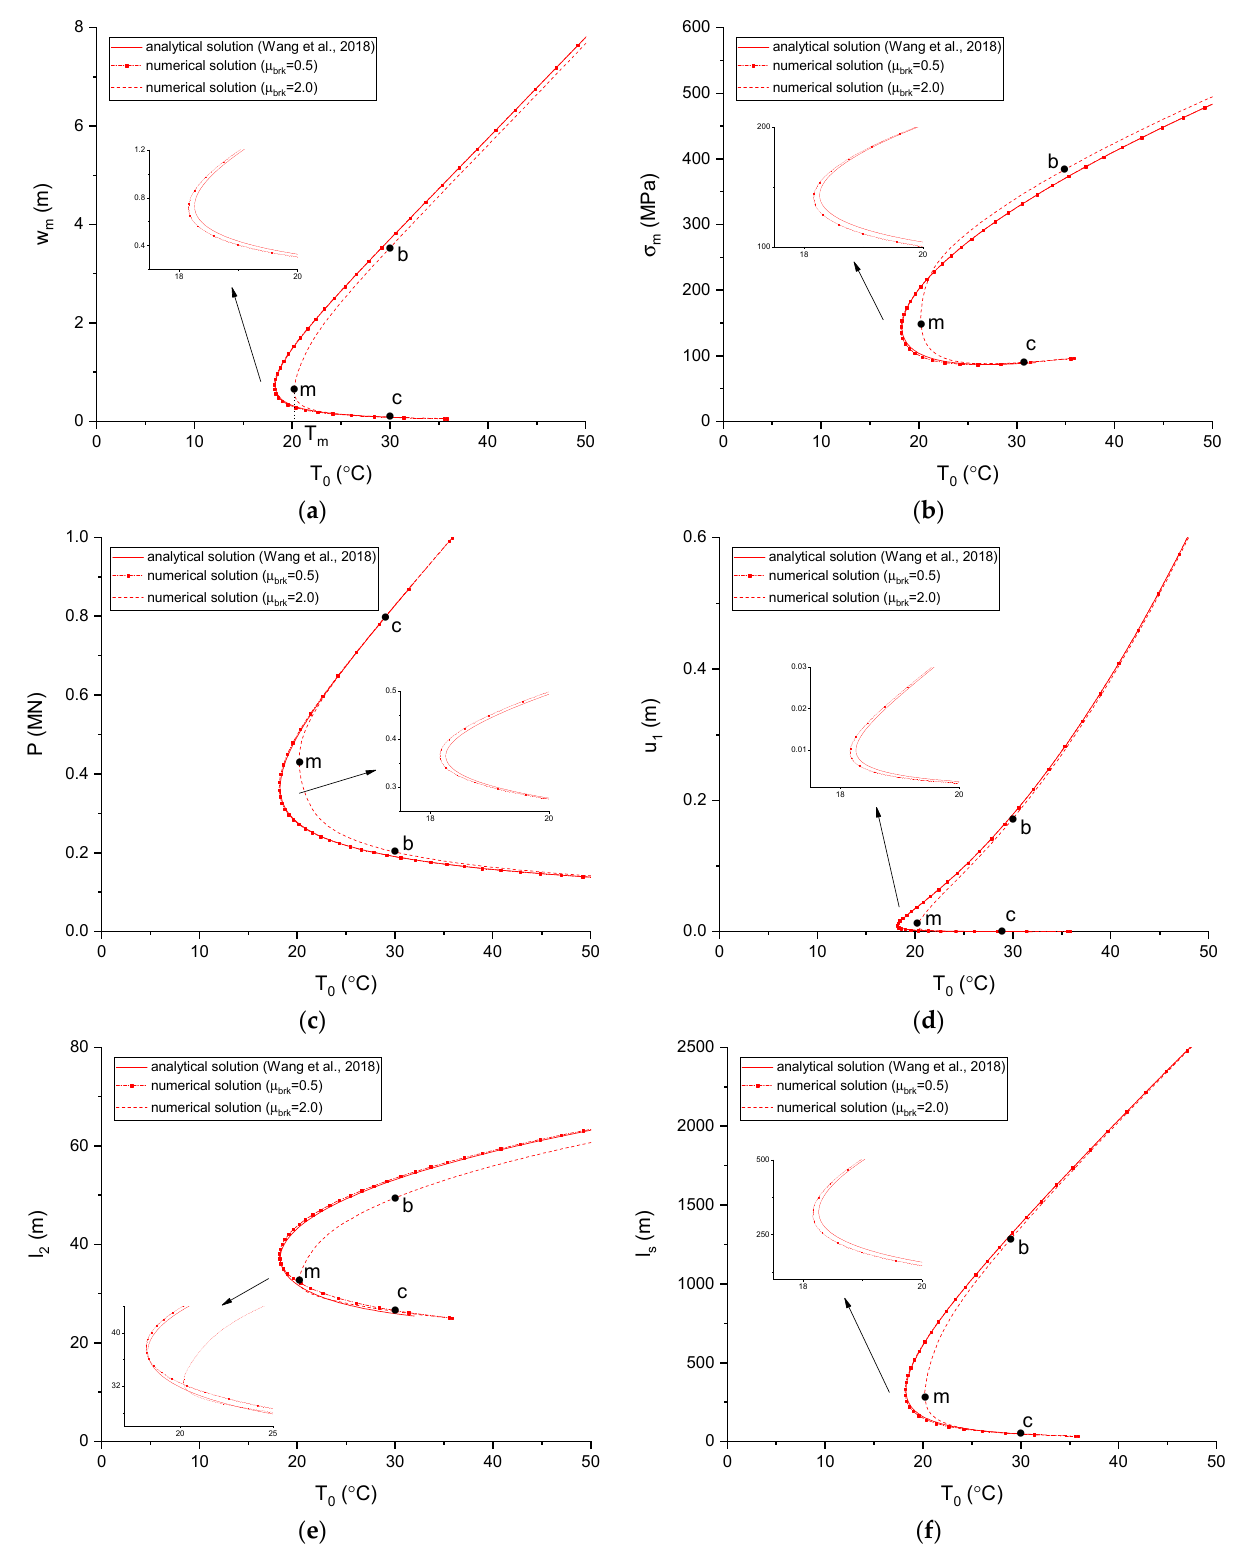
Figure 4. Validation. ( a ) Displacement amplitude w m . ( b ) Maximum stress σ m . ( c ) Axial force P . ( d ) Thermal expansion u 1 . ( e ) Half-length of buckled region l 2 . ( f ) Half-length of feed-in region l s . ( v om = 0.1 m, µ s = 0.1)